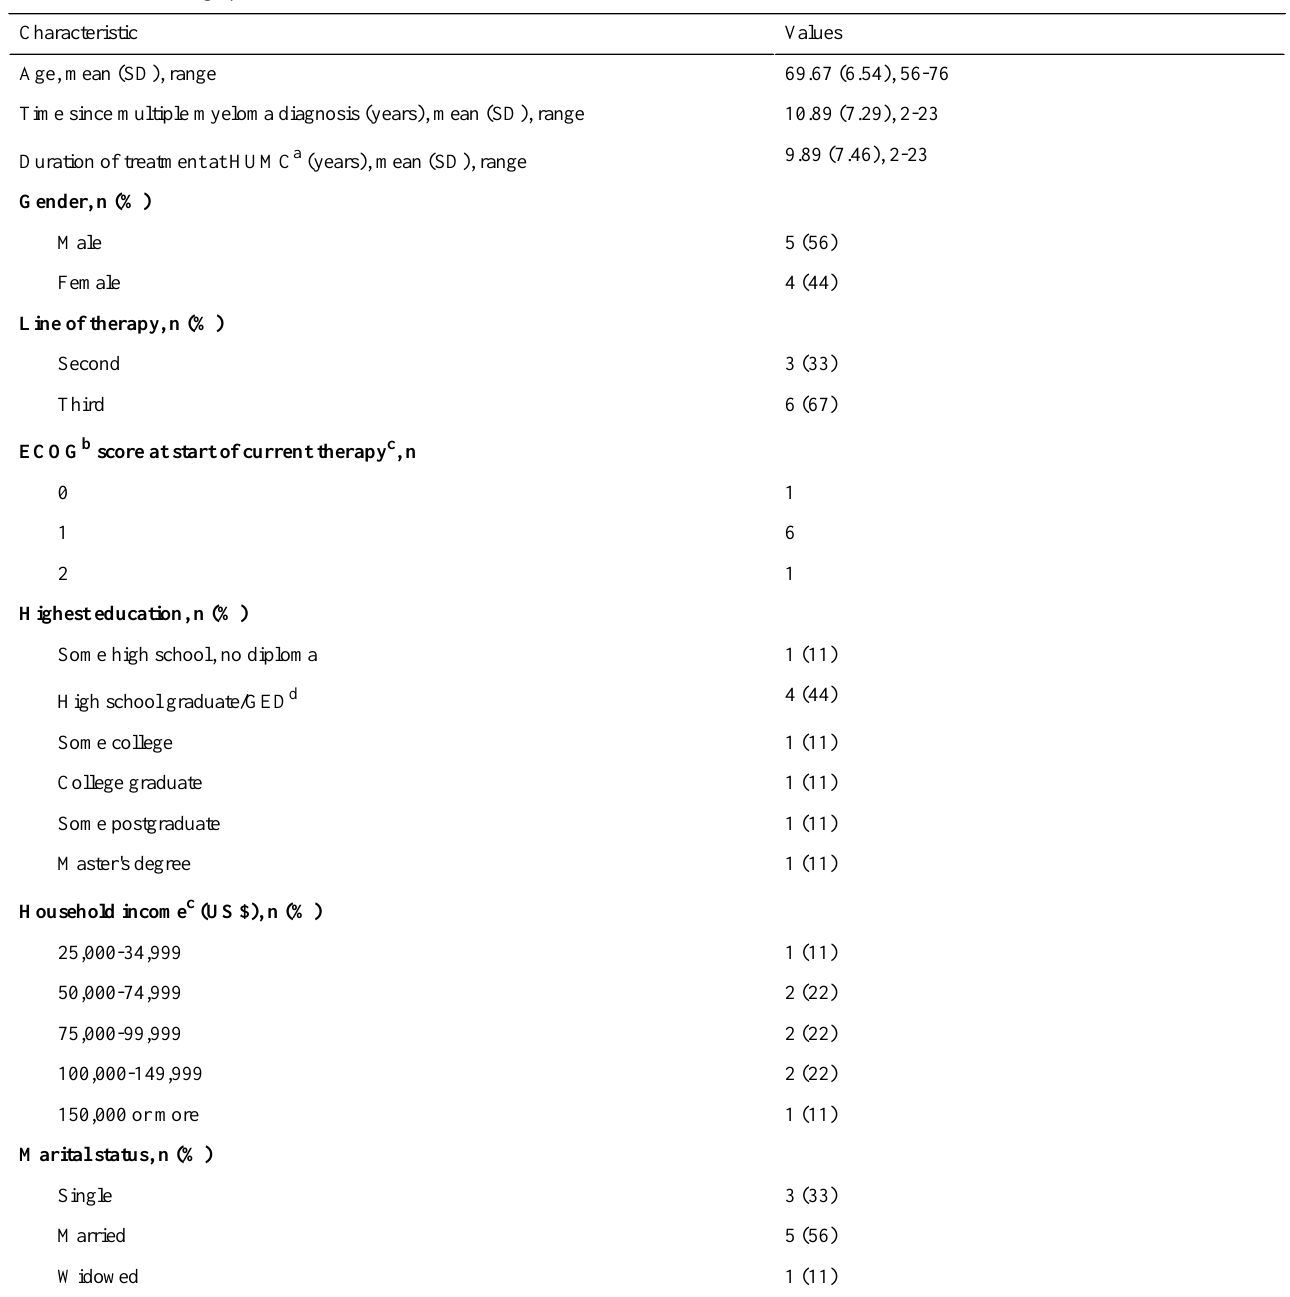
Table 3. Patient demographic information and clinical